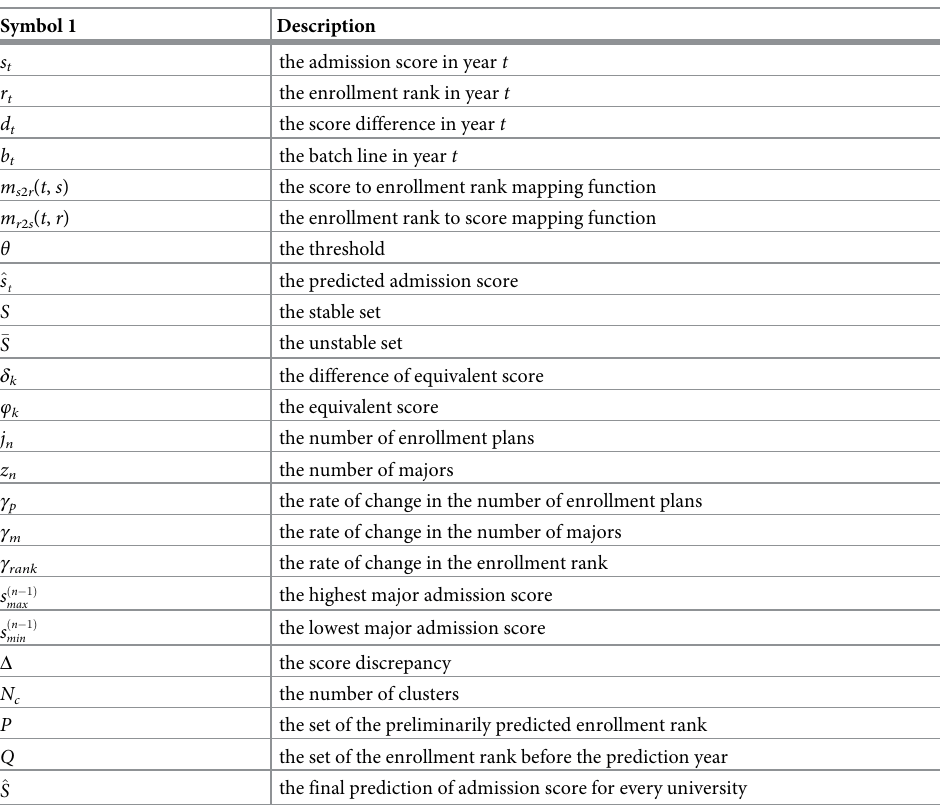
Table 1. The notation of each